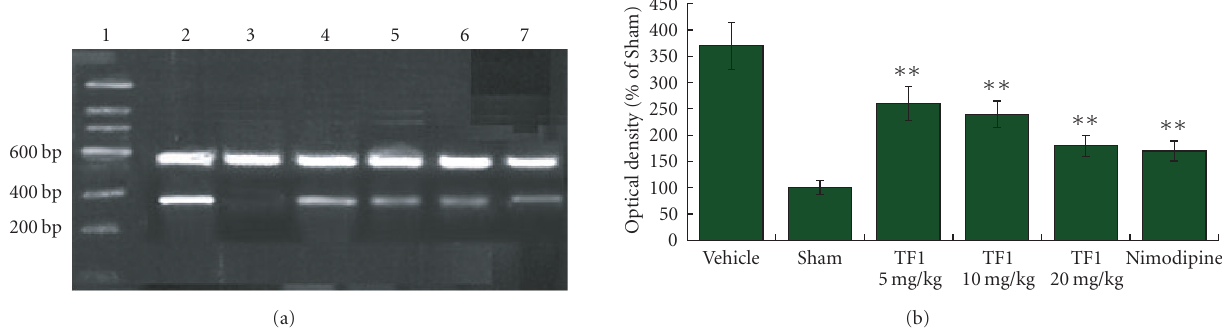
Figure 5: (a) The mRNA expression of COX-2 was assessed by using RT-PCR as standardized by coamplifying the housekeeping gene β - actin. Lanes 1–7: Marker, Vehicle, Sham, TF1 (5mg · kg − 1 ), TF1 (10mg · kg − 1 ), TF1 (20mg · kg − 1 ), Nimodipine. (b) Statistical analysis